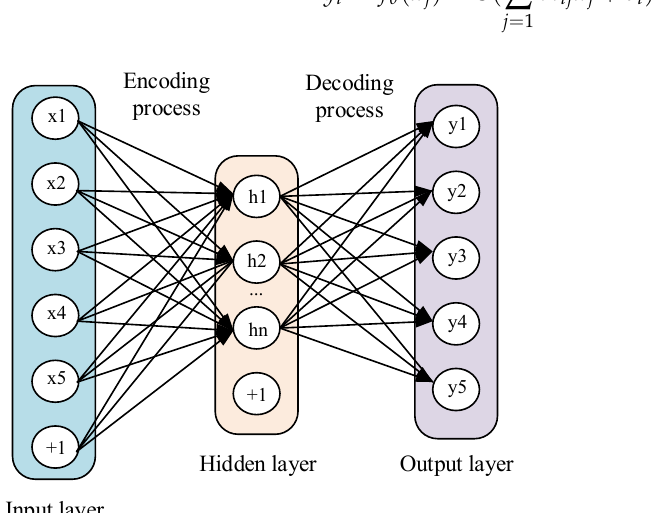
Figure 1. Autoencoder: the schematic diagram of both the encoding and the decoding process. In Equation (1), y i is the activation value of the hidden layer, W ij is the weight coeffi- cient, b i is the offset vector of the hidden layer, and S ( x ) represents the activation function. The sigmoid function is employed herein. The minimized reconstruction error is defined